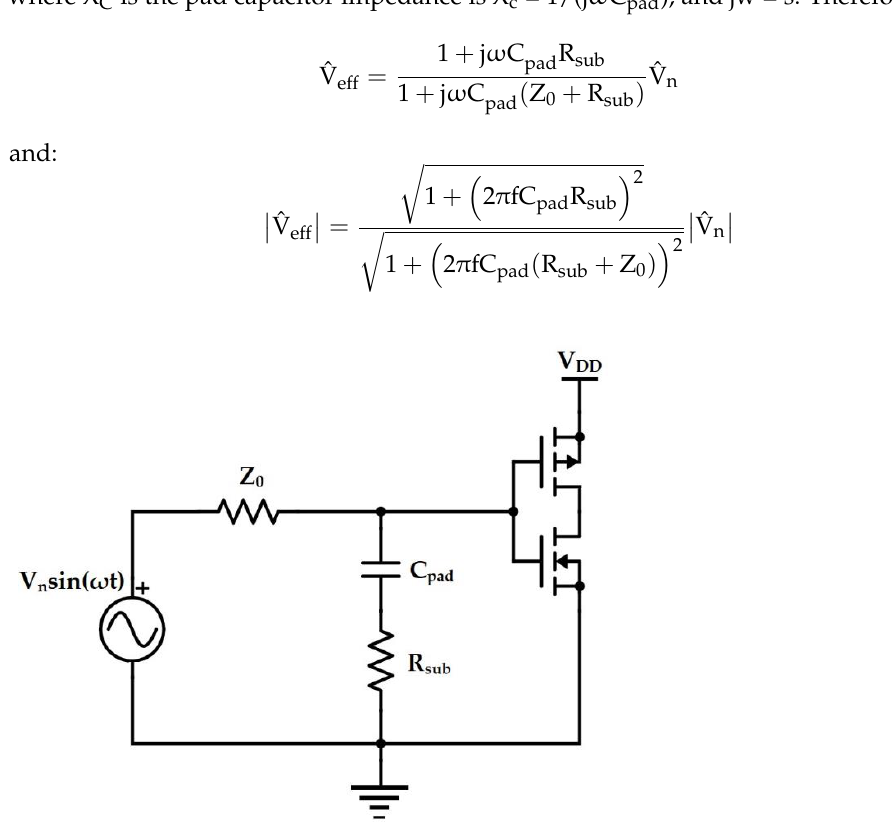
Figure 4. Simplified schematic of the experimental test circuit showing Z 0 , C pad , and R sub . The zeros and poles of the system are defined as the roots of the numerator and the denominator of the transfer function, respectively. According to Equation (8), the zeros and poles of the system will be at frequencies f 0 and f p , respectively, given by: